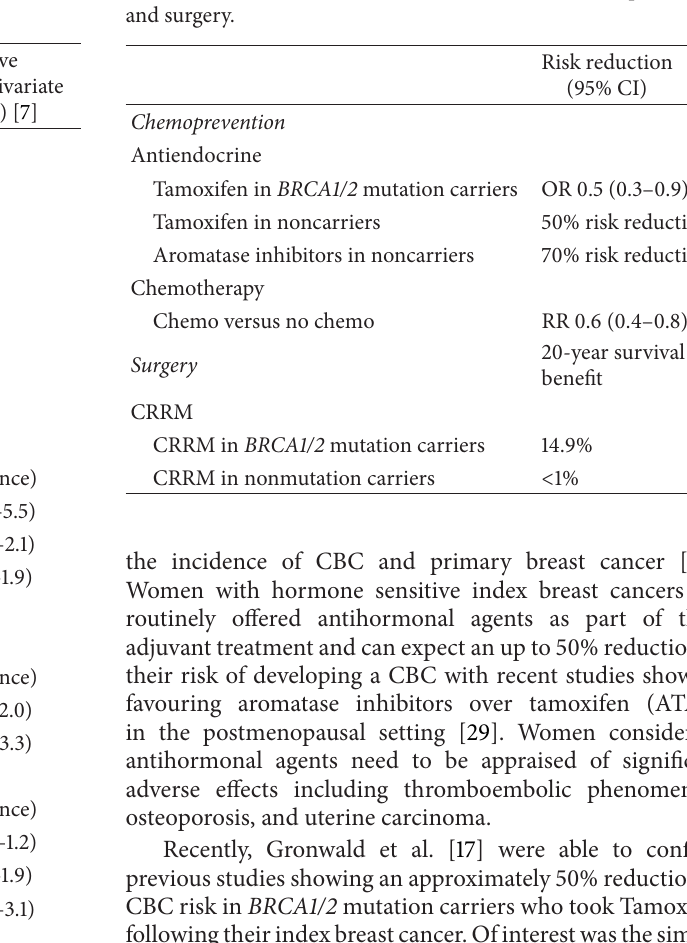
Table 1: Risk factors for developing CBC (estimated annual risk) [4, 7].